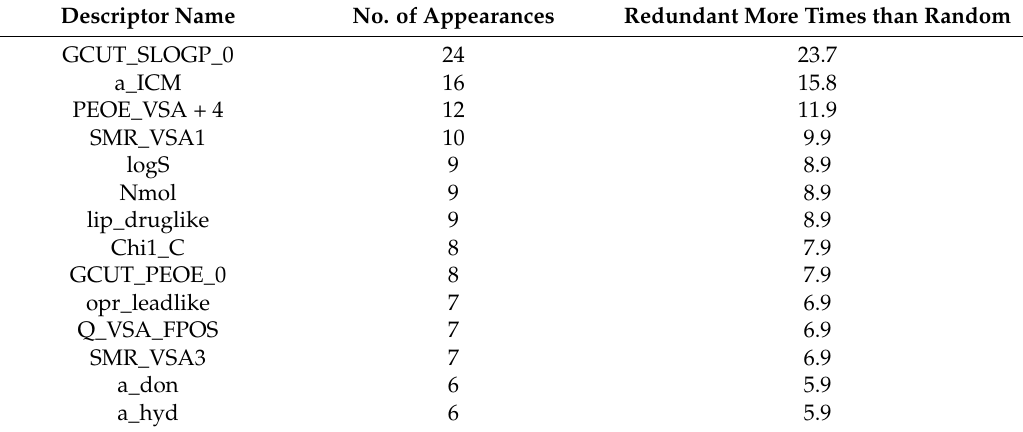
Table 2. Number of appearances of descriptors within the set of the best unique filters. The full list of descriptors is presented in the Supporting Information (Table S2). Definition for descriptors and methods of its calculation could be found in the site if Chemical Computing Group